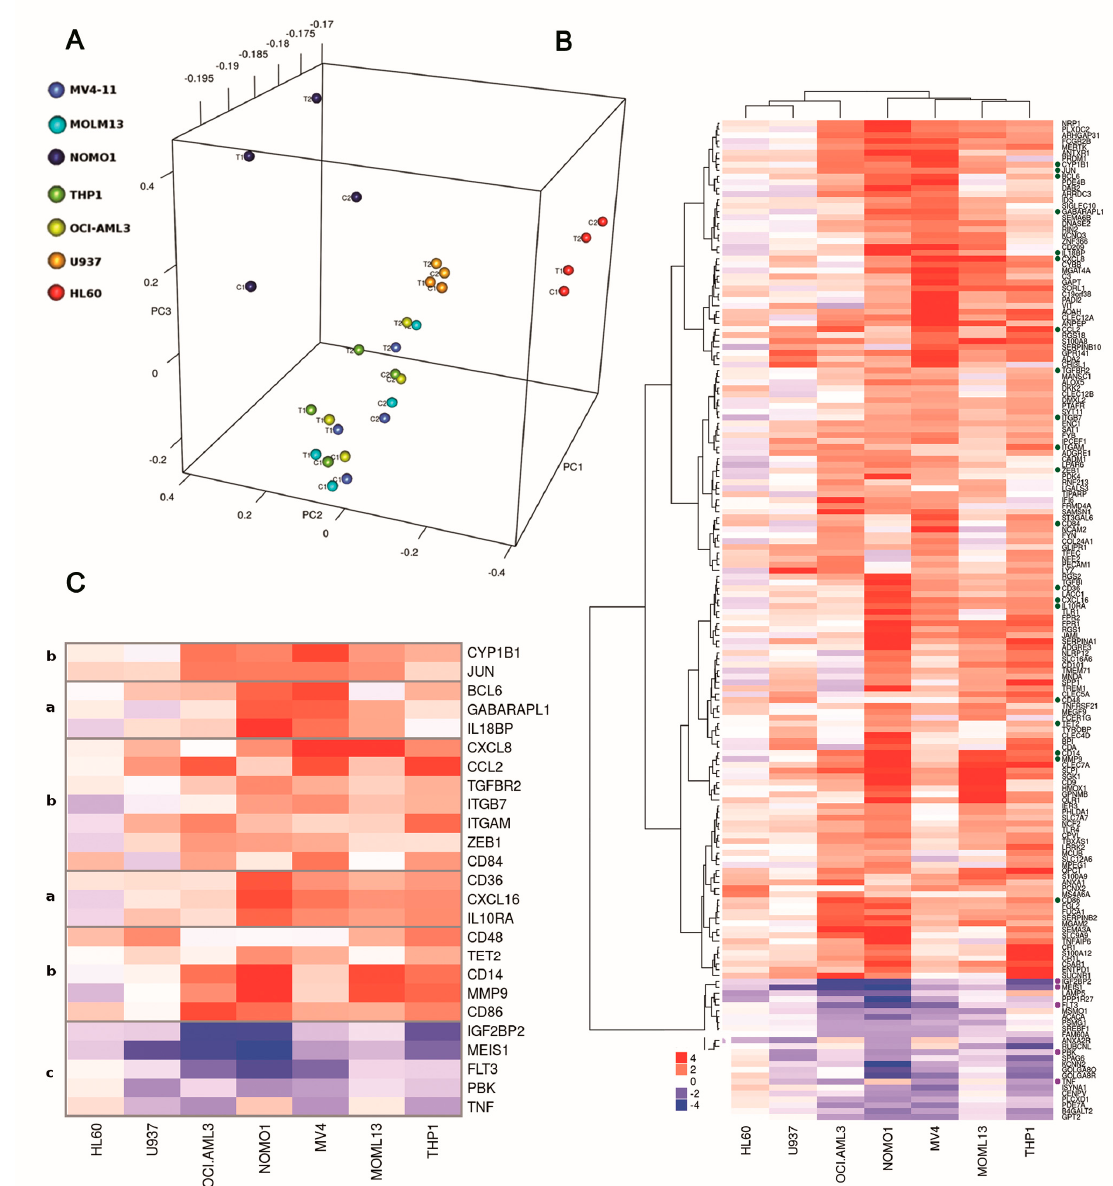
Figure 4. Global gene expression profiling in MLL -r and non- MLL -r human AML cell lines treated with Pinometostat. All AML cell lines were treated with 1 µM Pinometostat or DMSO 0.01% for 8 days, because in previous analyses, this drug exposure time significantly impacted proliferation, di ff erentiation, and transcription processes. ( A ) Principal component analysis (PCA) plot of gene expression data. Two replicates for each cell line and condition are shown. C1: control cells, replicate 1; T1: treated cells, replicate 1; C2: control cells, replicate 2; T2: treated cells, replicate 2. ( B ) Heatmap and hierarchical clustering of fold changes in gene expression in response to Pinometostat for the 171